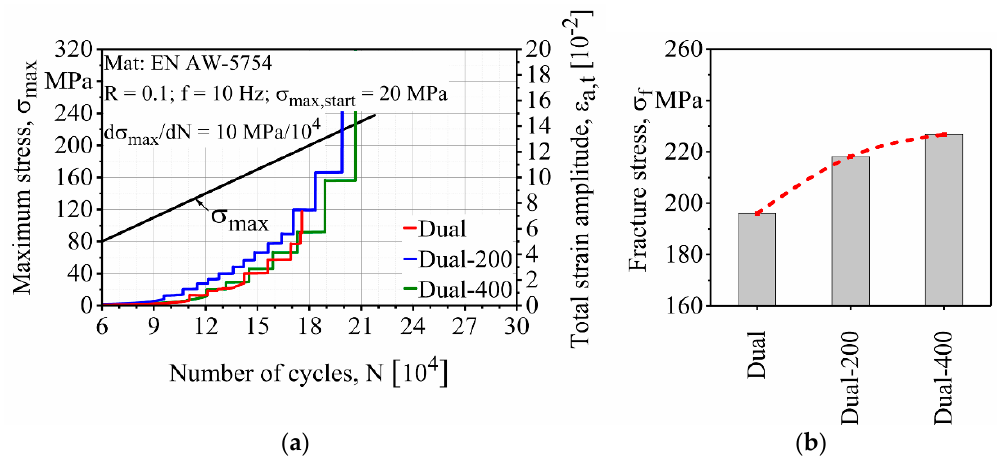
Figure 13. Effect of the surface finishing process on the ( a ) load increase test and ( b ) fracture stresses of dual-rotational friction stir welded (FSW) specimens.